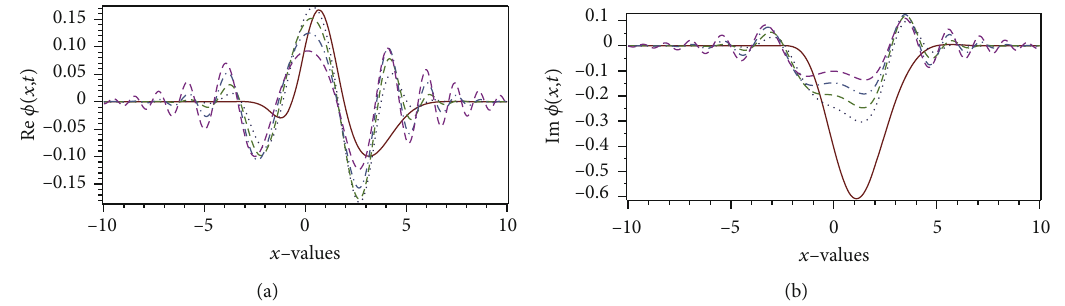
Figure 4: Real and imaginary parts of solution of (73) for a = 1/3, b = 1/2, c = 5/2, k = 1, t = 1/2, t = 2, t = 3, t = 5, t = 10, and f ð x Þ = u ð x Þ